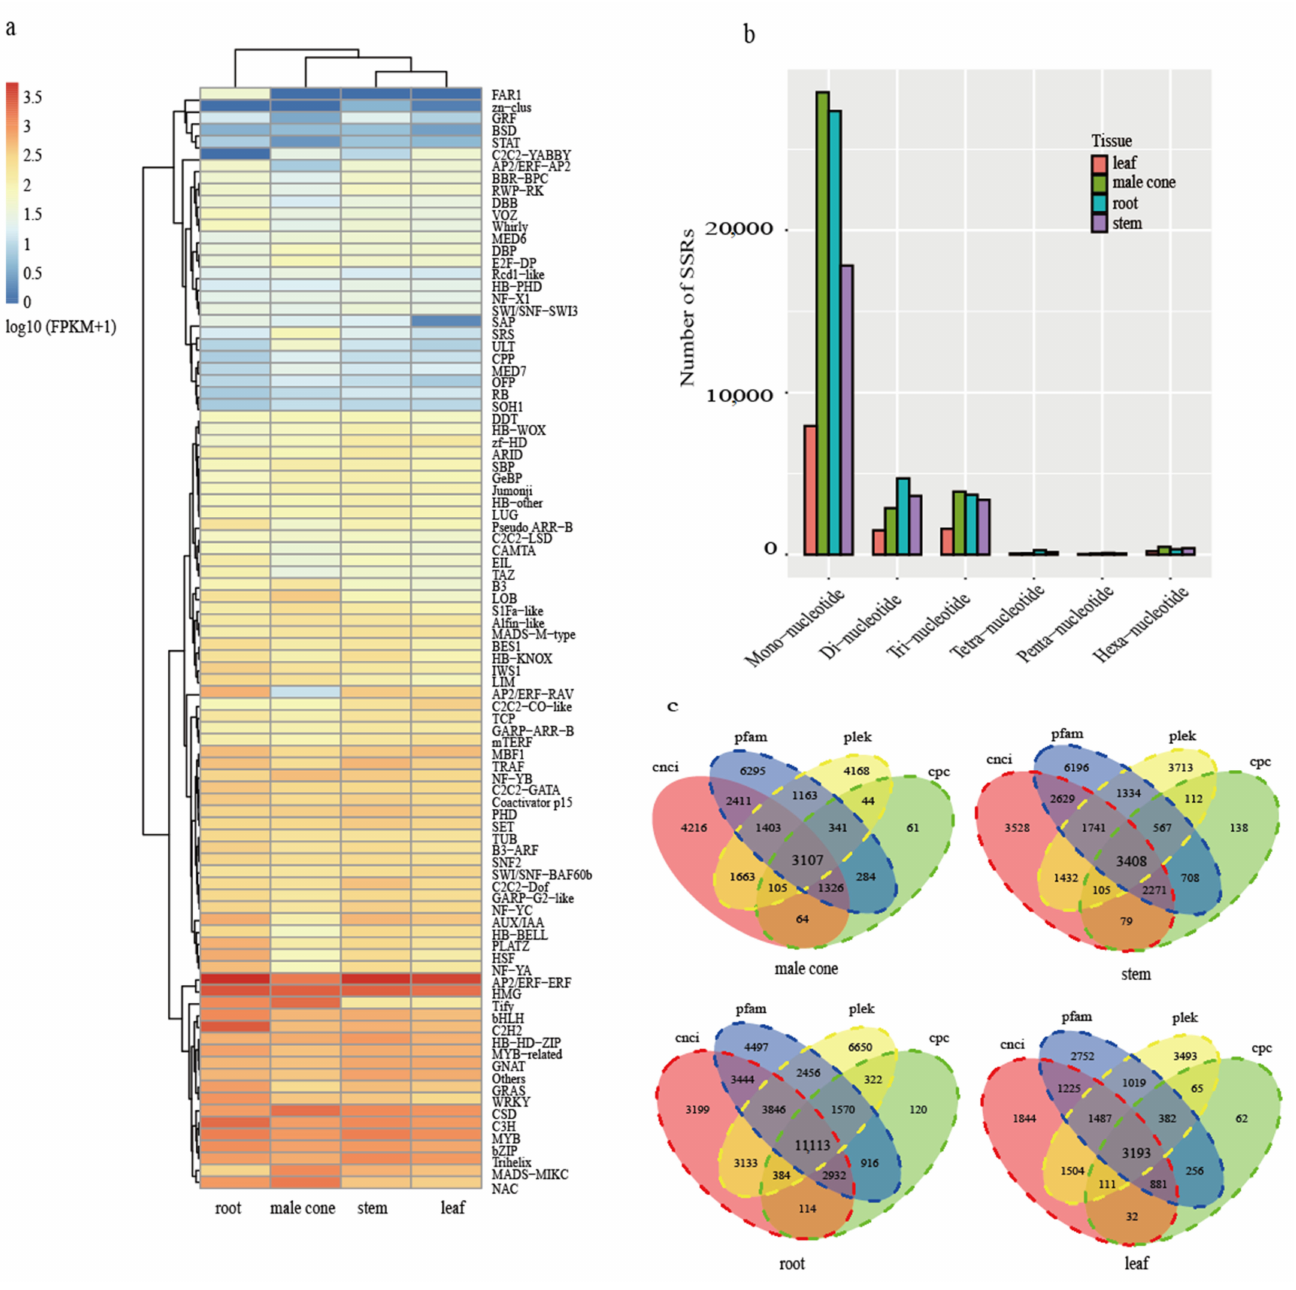
Figure 2. Identification of the transcription factors (TFs), simple sequence repeats (SSRs) andlong non-coding RNAs (lncRNAs). ( a ) Expression profiles of transcription factor families in four tissues; ( b ) the histogram representing the number of different types of SSRs; ( c ) Venn diagram of lncRNAs predicted by four different